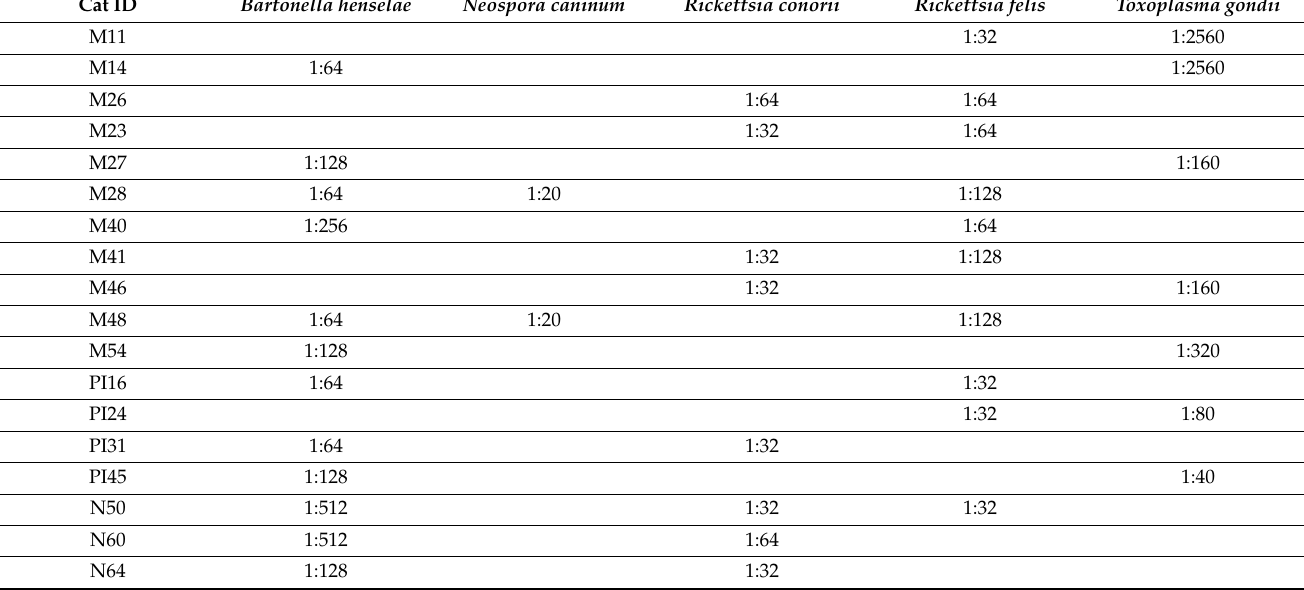
Table 1. Details of the cats testing positive to two or more